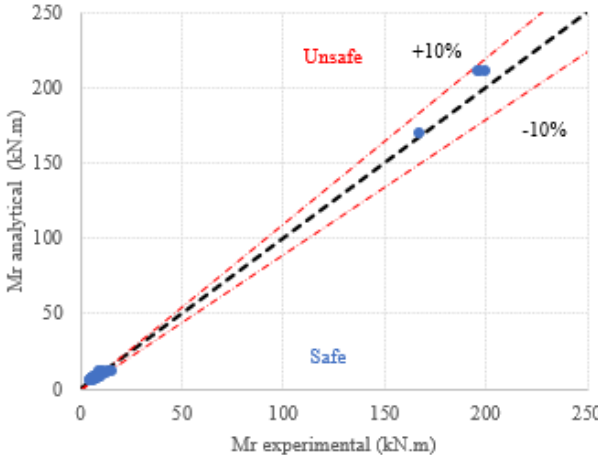
Figure 5. Post-fire moment capacity: analytical vs.